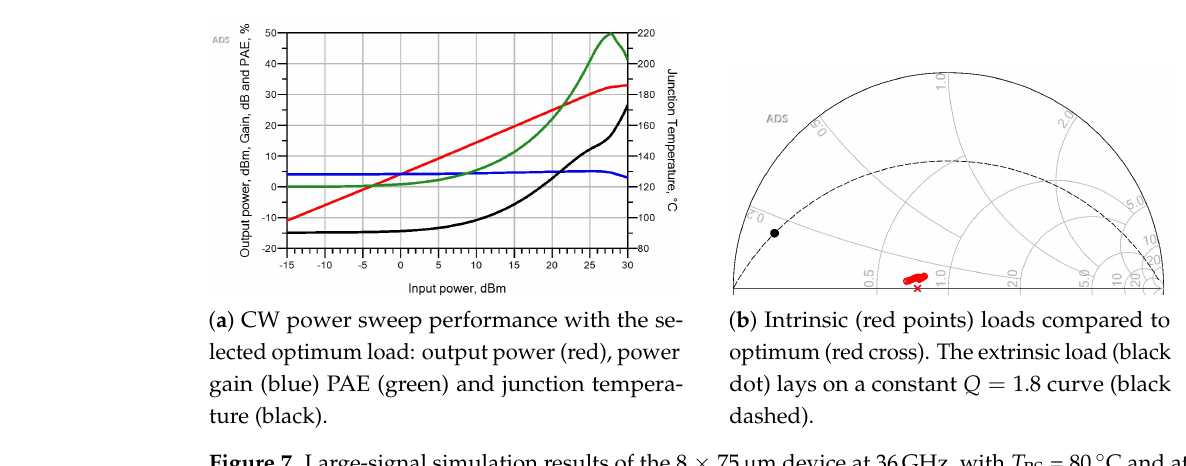
Figure 7. Large-signal simulation results of the 8 × 75 µ m device at 36GHz, with T BS = 80 ◦ C and at the selected bias point.